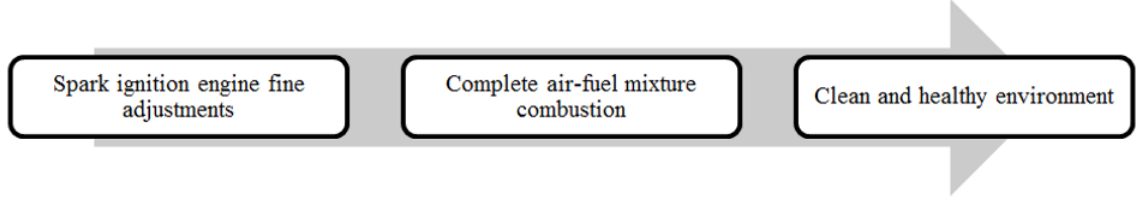
Figure 1. The desired influence direction from engine to environment quality.